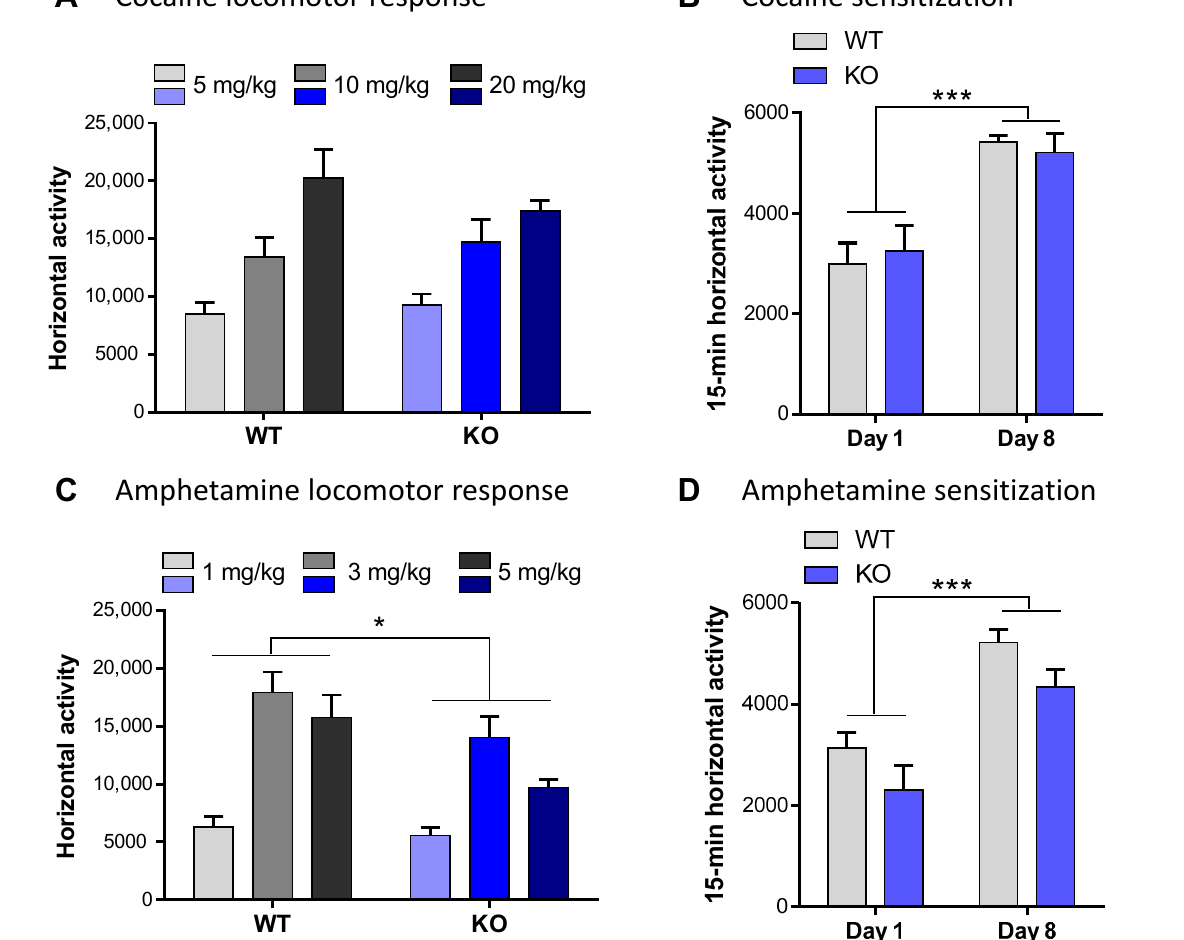
Figure 4. Addiction-like behavior in VMAT2 DBHcre mice. ( A ) Acute locomotor response (horizontal activity) to cocaine for 2 h following i.p. injection of 5, 10, or 20 mg/kg in the WT and KO mice of the VMAT2 DBHcre (n = 6 per group; genotype: F (1,30) = 0.04, p = 0.84; concentration: F (2,30) = 19.6, p < 0.001; genotype × concentration: F (2,30) = 1.01, p = 0.38). ( B ) Locomotor sensitization after repeated i.p., administration of 20 mg/kg cocaine over 6 days followed by 48 h of withdrawal in the WT and KO mice of the VMAT2 DBHcre (n = 10 per group; genotype: F (1,18) = 0.003, p = 0.95; day: F (1,18) = 54.04, *** p < 0.001, genotype × day: F (1,18) = 0.64, p = 0.43). ( C ) Acute locomotor response (horizontal activity) to amphetamine for 1 h following i.p. injection of 1, 3, or 5 mg/kg in the WT (1 mg/kg n = 5, 3 mg/kg n = 9, 5 mg/kg n = 6) and KO (1 mg/kg n = 6, 3 mg/kg n = 9, 5 mg/kg n = 6) mice of the VMAT2 DBHcre (genotype: F (1,35) = 6.87, * p = 0.013; concentration: F (2,35) = 19.2, p < 0.001; genotype × concentration: F (2,35) = 1.13, p = 0.33). ( D ) Locomotor sensitization after repeated i.p. administration of 3 mg/kg amphetamine over 6 days followed by 48 h of withdrawal in the WT and KO mice of the VMAT2 DBHcre (n = 9 per group; genotype: F (1,16) = 4.11, p = 0.06; day: F (1,16) = 55.92, *** p < 0.001, genotype × day: F (1,16) = 0.0081, p = 0.93).